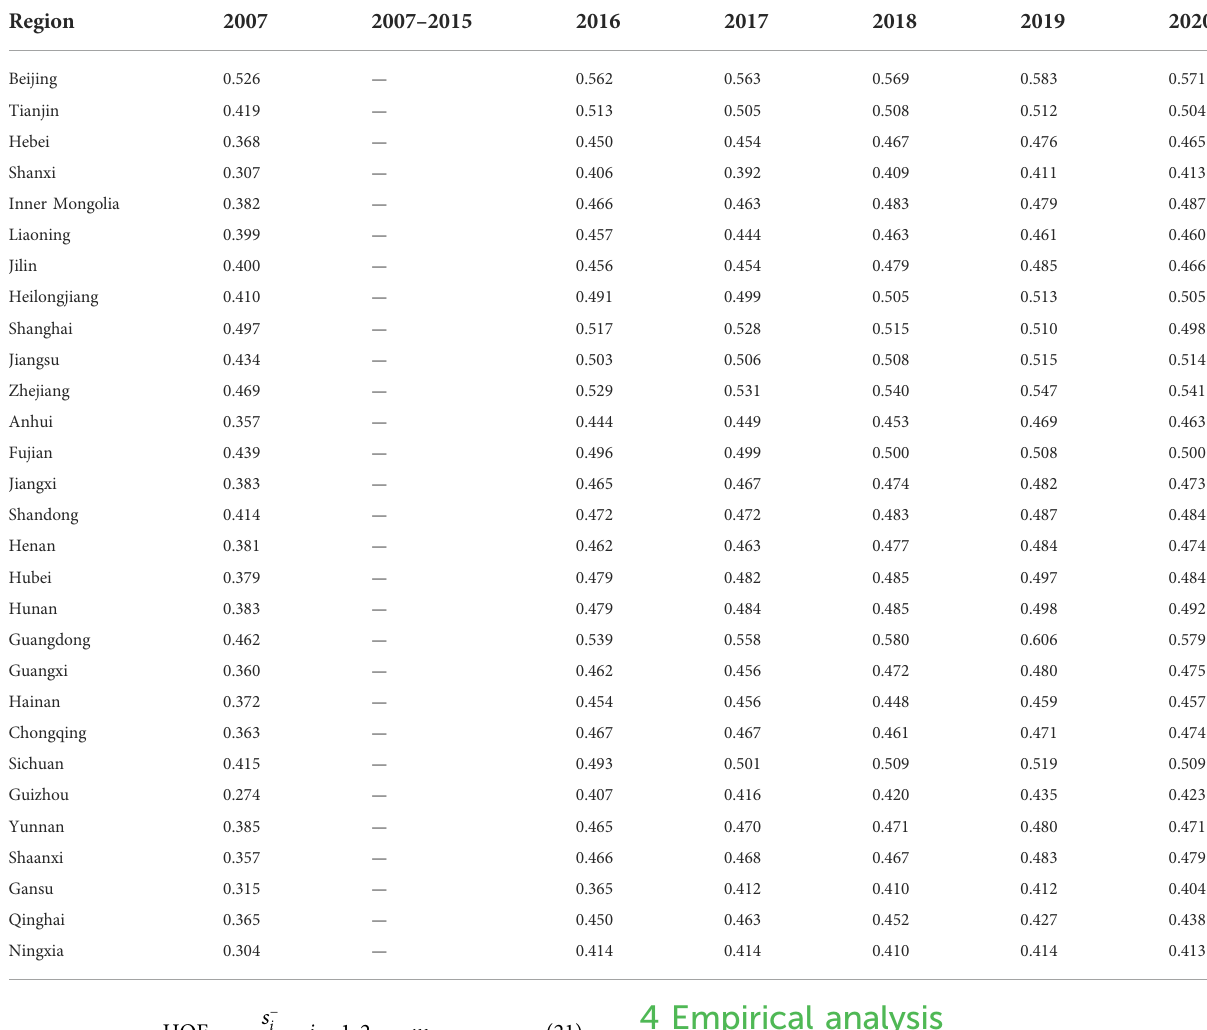
TABLE 4 High-quality economic development index of provinces and cities in China.